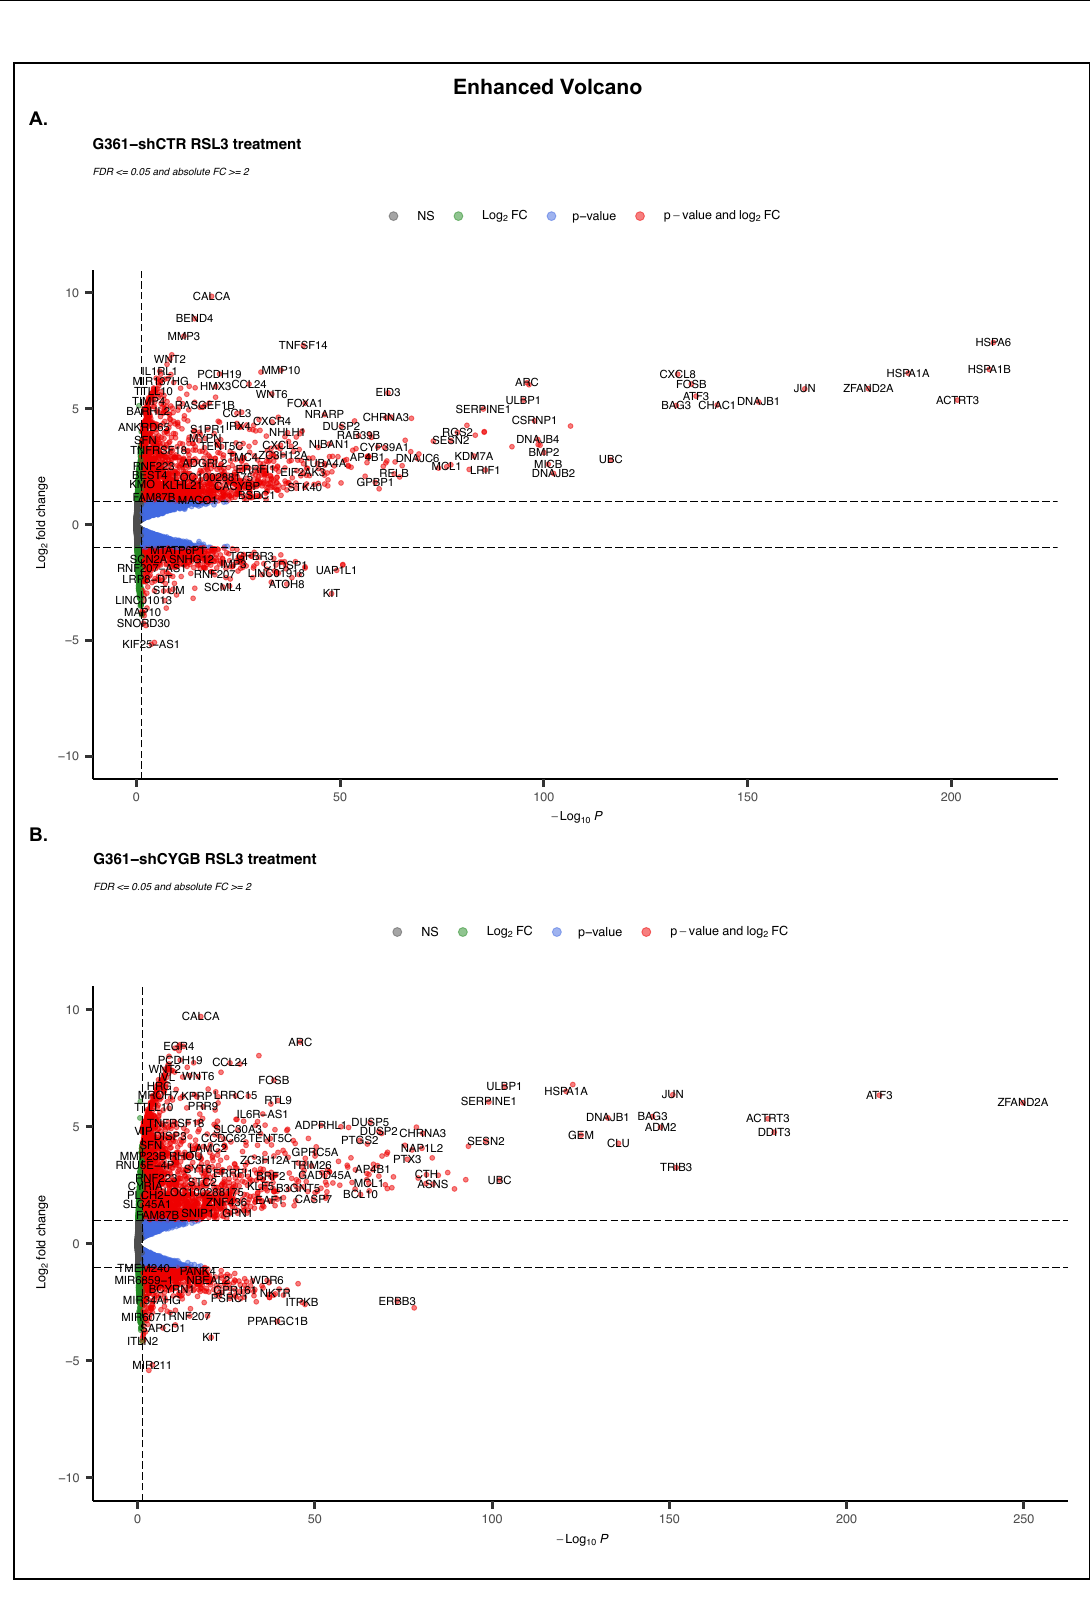
Figure 5. Enhanced volcano RSL3 treatment. Volcano representation of the differential expression analysis (DESeq2) of RSL3-treated G361-shCTR ( A ) and G361-shCYGB cells ( B ). Differentially ex- pressed genes were represented based on their Log 2 fold change (Log 2 FC) and − Log 10 p -adjusted value (-Log 10 P